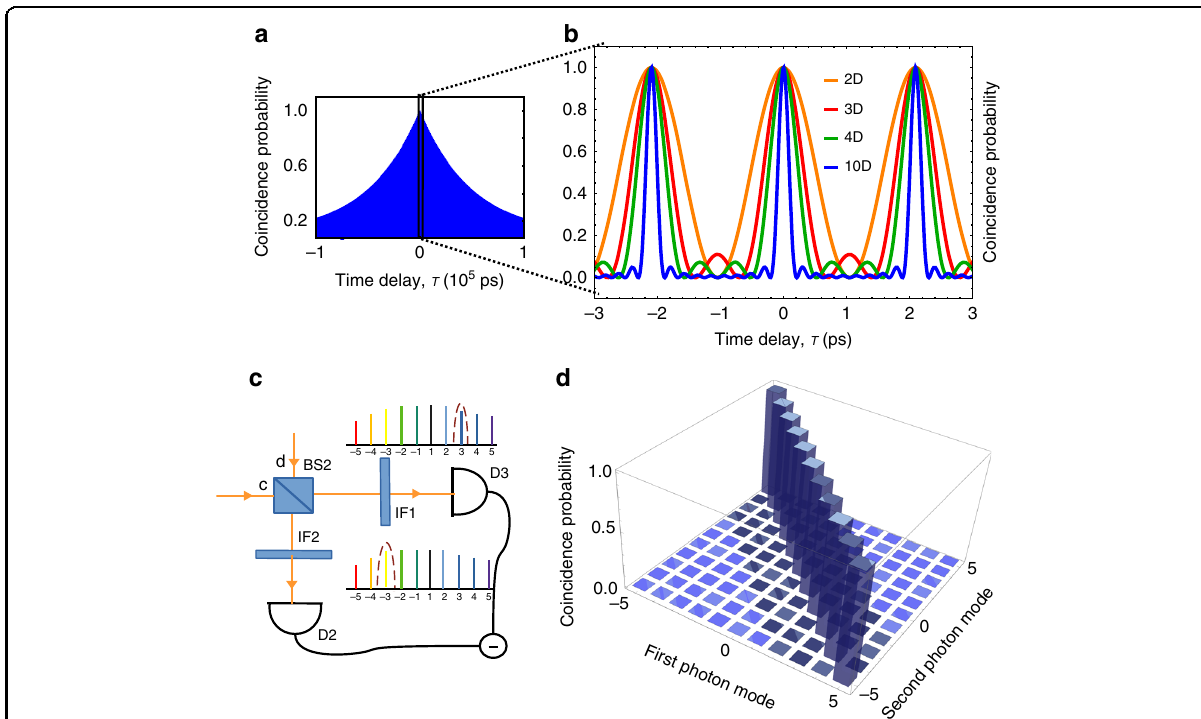
Fig. 4 The coincidence probability P2 ( τ ) for an entangled comb. The coincidence probability P 2 ( τ ) for an entangled comb. a plotted over a large time delay which shows a slow decrease in coherence due to the narrow width of cavity resonances. b Comparison of P 2 ( τ ) between two (orange), three (red), four (green) and ten (blue) dimensional entangled photon states. c Coincidence measurement setup (shown in Fig. 1) represents the mixing between different comb modes. d Coincidence measurement for the 10 entangled comb pairs which are generated from the cavity length 98.417µm. The small off-diagonal components represent mixing coming from the bandwidth of the optical fi lter used for the measurement (chosen here to be 100 pm).